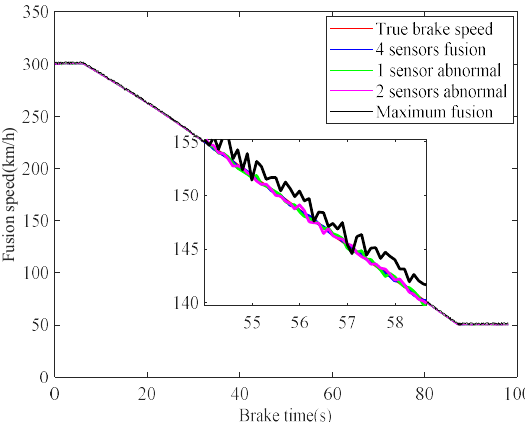
Figure 19. Fusion of speed sensors.